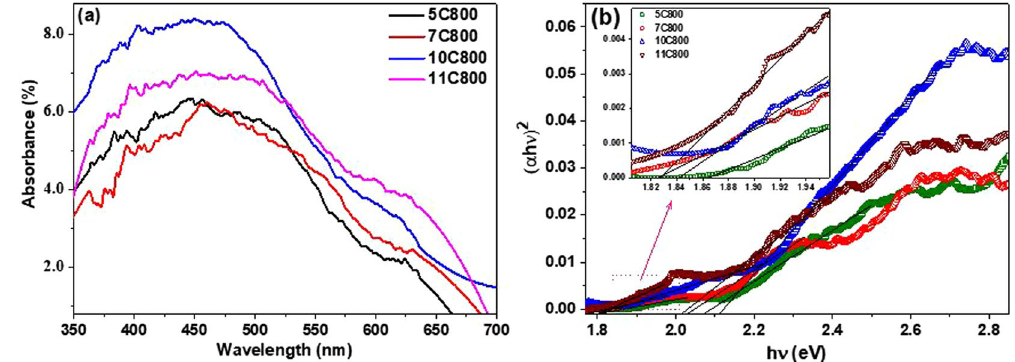
Figure 8. ( a ) UV-Vis absorption spectra and ( b ) Tauc plot depicting dual band-gap corresponding to dual absorbance of all the samples synthesized at 800 °C.